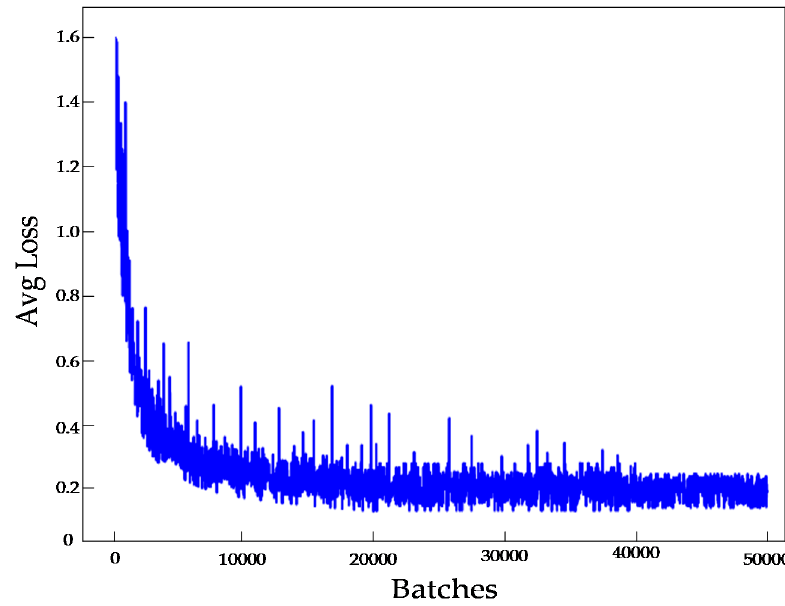
Electronics 2021 , 10 , x FOR PEER REVIEW Figure 8. The function curve of average loss. Figure 8. The function curve of average loss.